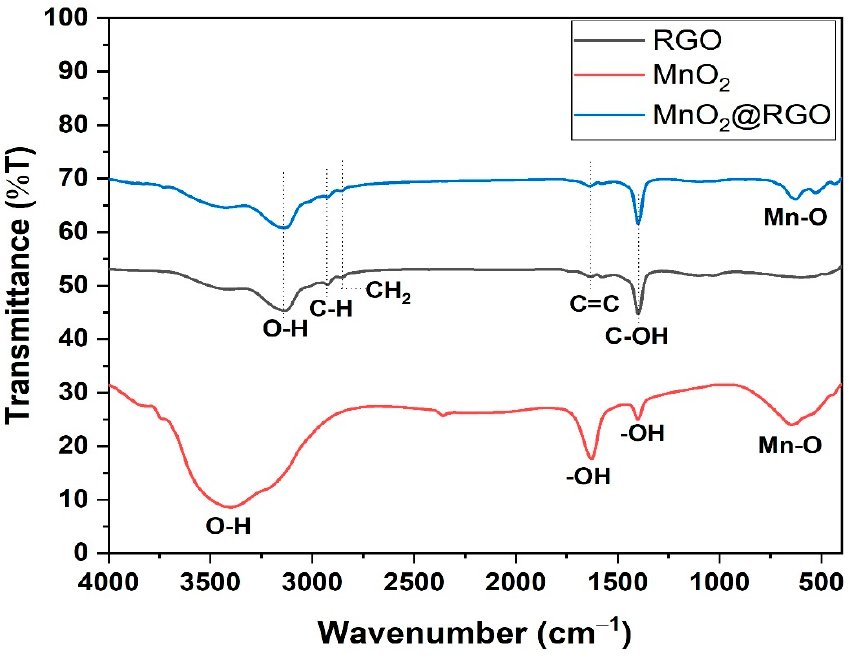
Figure 4. FTIR spectra of RGO nanosheets, MnO 2 nanoparticles and MnO 2 @RGO nanocomposite.